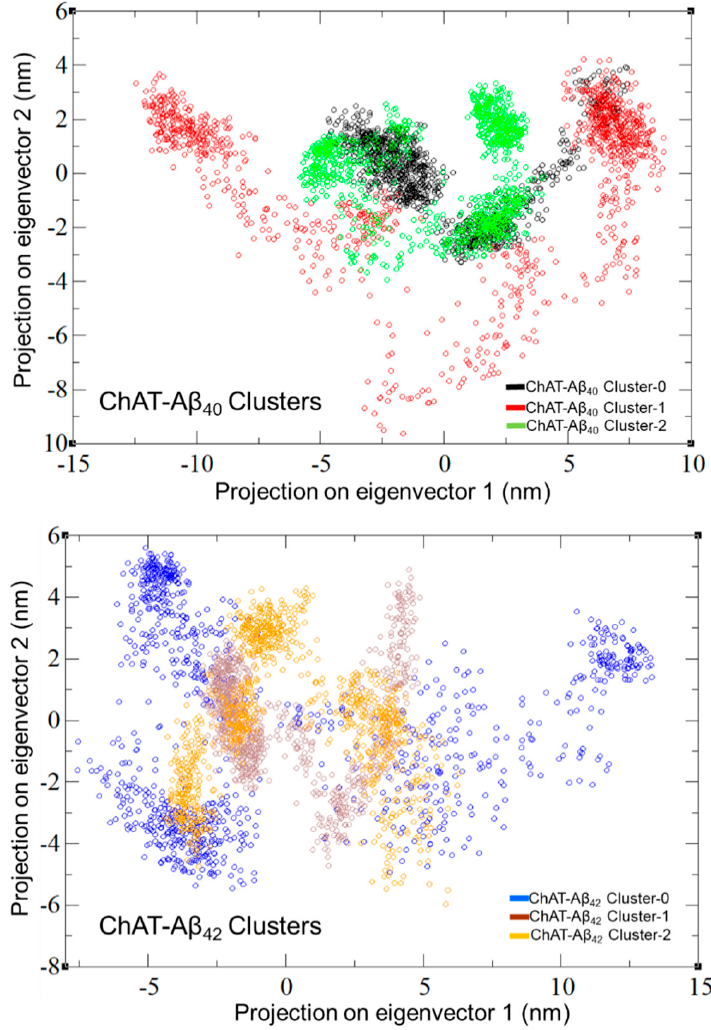
Figure 6. Representation of the projection of the first two principal components for the ChAT-A β complex system. Each dots represent a specific conformational state of the ChAT protein in the complex system with A β . Congregated clusters of the dots indicate that the protein did not go through any major conformational changes, whereas the widespread dots indicate more flexibility of the protein in the complex and, hence, some major conformational changes that might take place. Overall, the graphs illustrate the close concentrated distribution of the conformational sampling for the majority of the ChAT-A β complexes clusters except for the ChAT-A β 40 cluster-1 and ChAT-A β 42 cluster-0, which exhibit widespread distribution of conformational sampling.